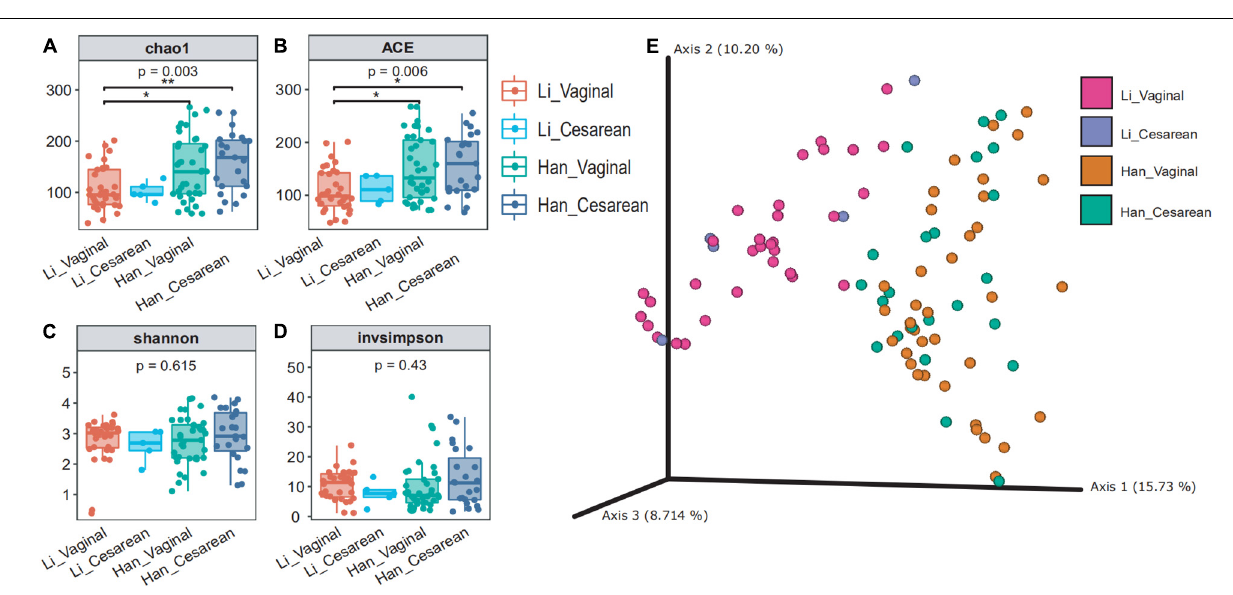
FIGURE 2 | Colostrum microbial diversity in China’s Hainan cohort grouped by ethnicity (Han/Li) and mode of delivery (cesarean/vaginal). chao1 (A) and ACE (B) reflected the abundance of the four groups (Li_Vaginal and Li_Cesarean and Han_Vaginal and Han_Cesarean), and Shannon (C) and invsimpson (D) reflected the diversity. (E) Bray–Curtis distance of the 97 samples using the full set of ASVs. The percentage of the variation explained by the plotted principal coordinates (PCs) was shown in